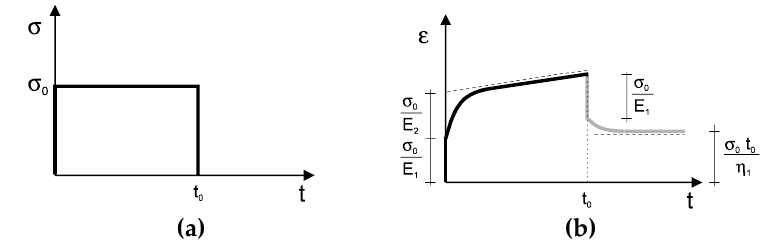
Figure 2. The creep curve in the Burgers model. The graphical finding of the parameters is presented. ( a ) – stress vs. time curve, ( b ) - strain vs. time curve.